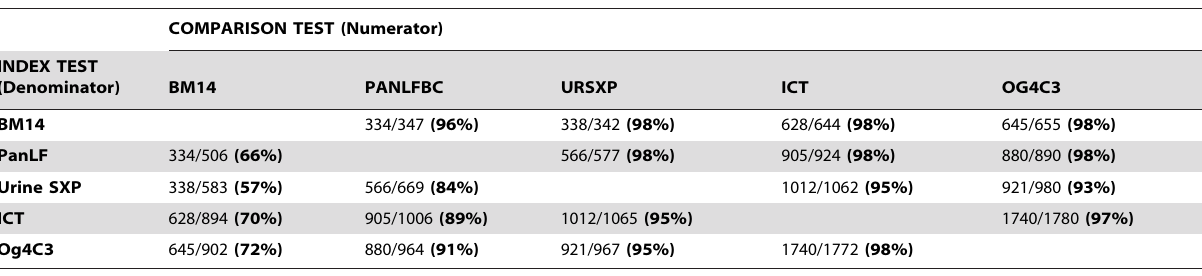
Table 11. Negative-to-negative test concordance in school survey.